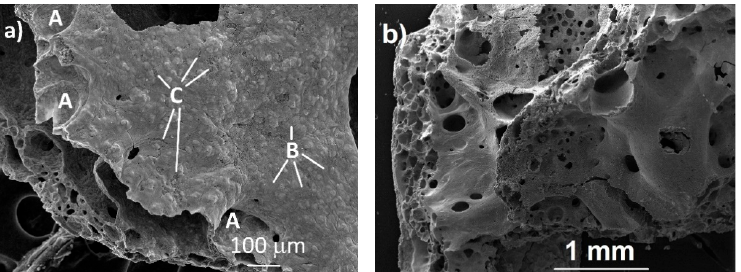
Figure 2. SEM micrographs of the ( a ) pre- and ( b ) post-laser-heated materials. A, B and C indicate the position of large holes, small grains, and pores, respectively.